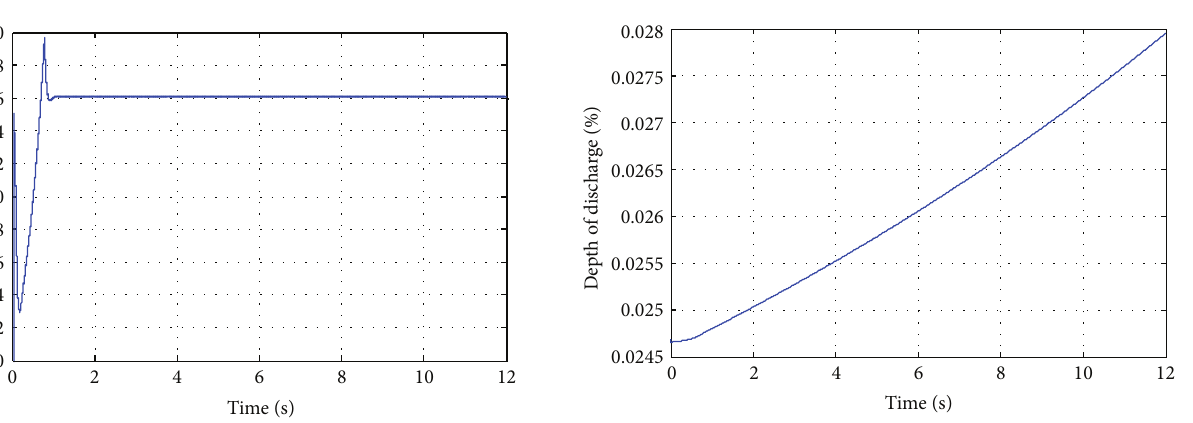
Figure 8: Evolution of Li-Ion battery power for the electric vehicle without air-conditioning.